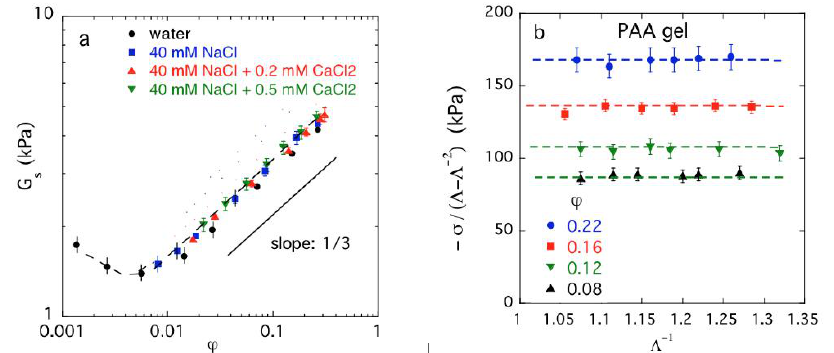
Figure 1. ( a ) Dependence of the shear modulus G s on the polymer volume fraction for PAA gels swollen in water and salt solutions. ( b ) Variation of σ /( Λ − Λ − 2 ) with Λ − 1 at different polymer volume fractions in PAA gels swollen in 40 mM NaCl solution with 0.2 mM and 0.5 mM CaCl 2 . In this figure σ is the nominal stress and Λ (= L/L o ), where L and L o are the lengths of the deformed and undeformed gel specimen, respectively) is the deformation ratio. Dashed lines are guide to the eyes. The uncertainties are the standard deviation estimated from five repeated measurements. We note that we use the concentration unit mM, which is a shorthand notation for mmol/L. This notation for concentration is used for notational economy below.